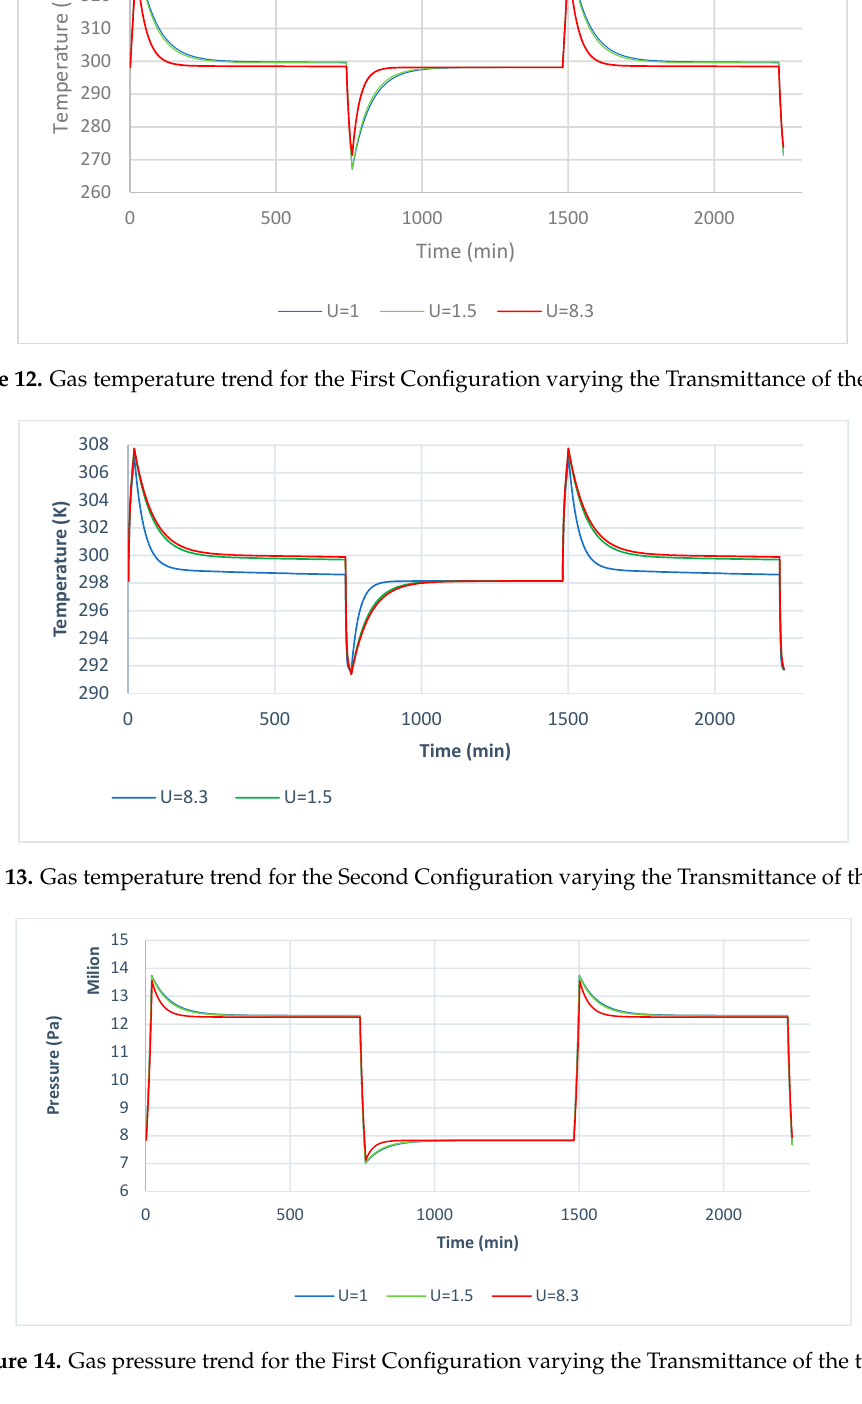
Figure 14. Gas pressure trend for the First Configuration varying the Transmittance of the tank.